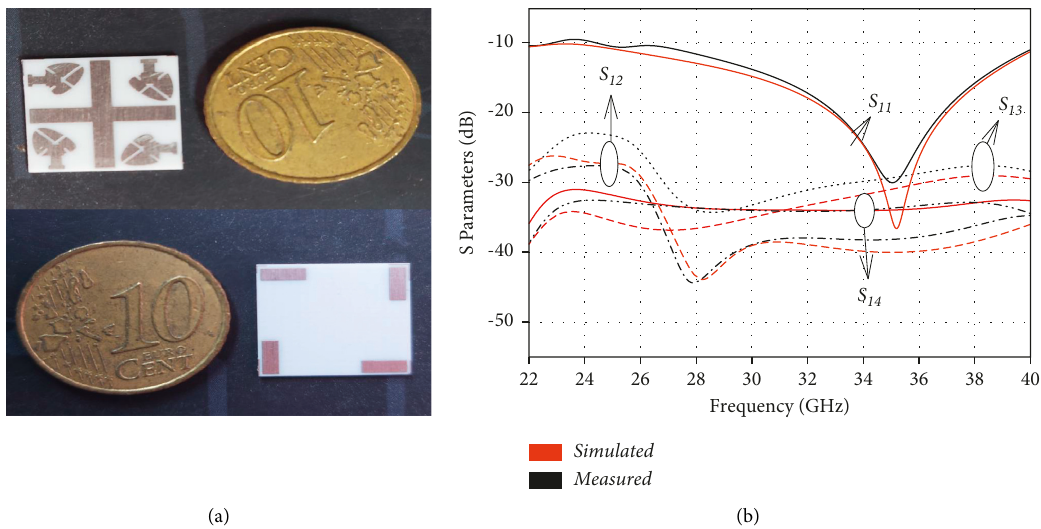
Figure 15: (a) Fabricated prototype of the proposed MIMO antenna with decoupling lines. (b) Simulated and measured S parameters of the MIMO configuration with decoupling